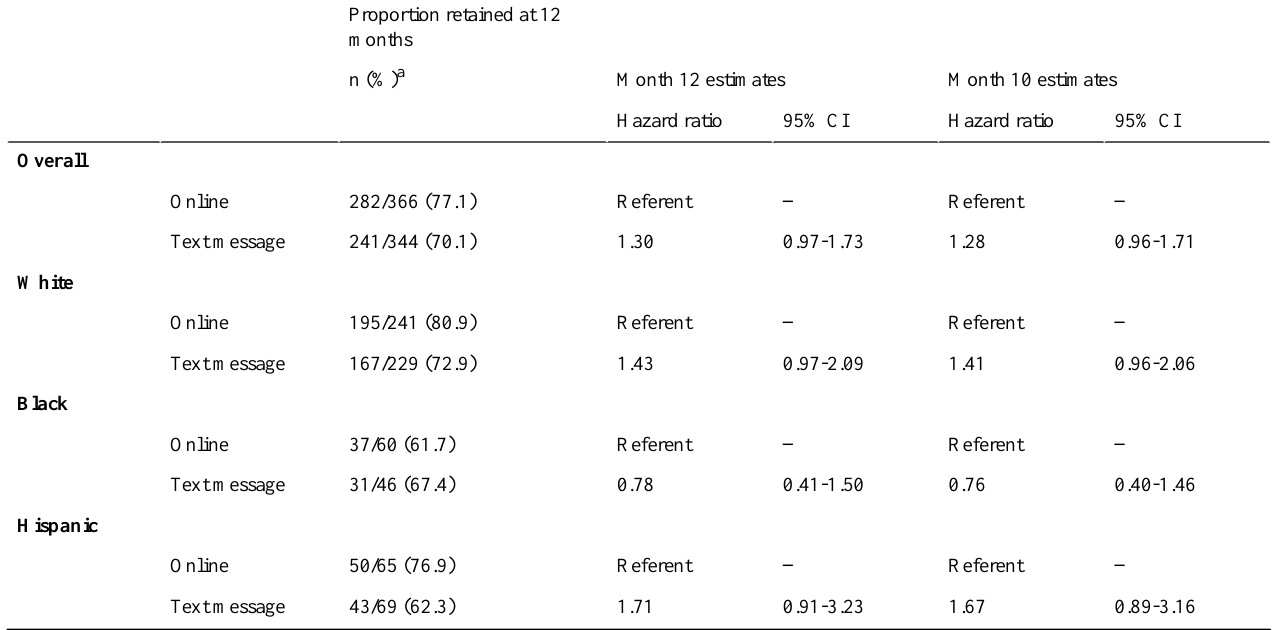
Table 2. Rate of loss-to-follow-up among men participating in a 12-month online study randomized to text message versus online follow-up, overall and stratified by race/ethnicity